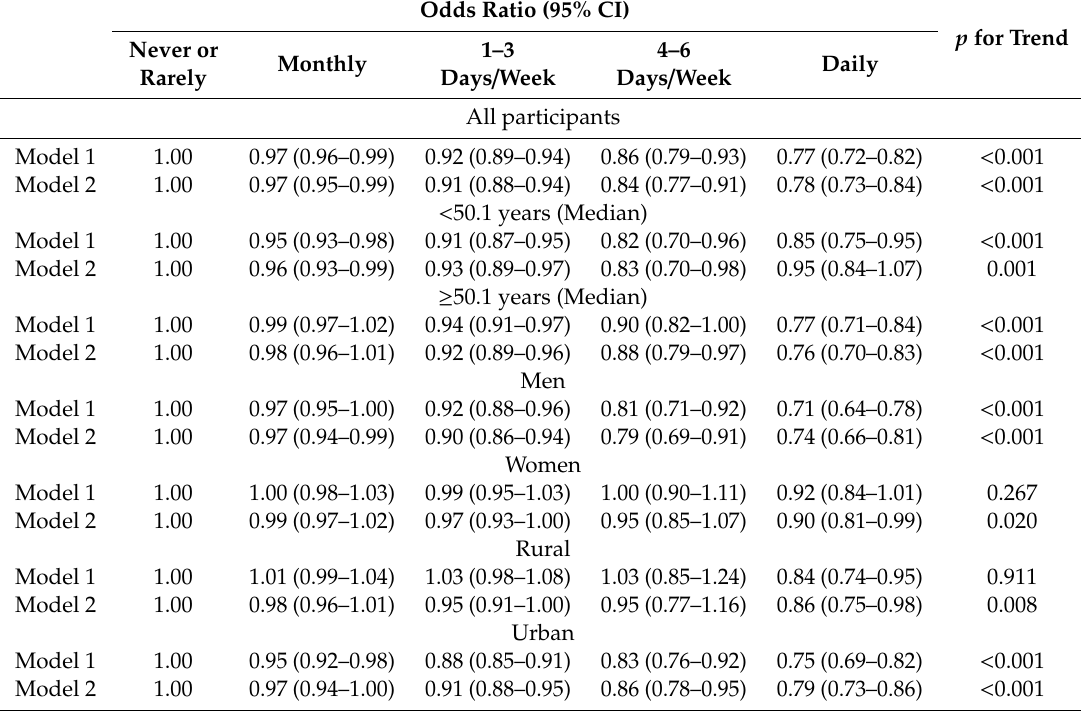
Table 2. Adjusted odds ratios of undiagnosed hypertension by coarse grain intake frequency and stratified results by age, sex, and